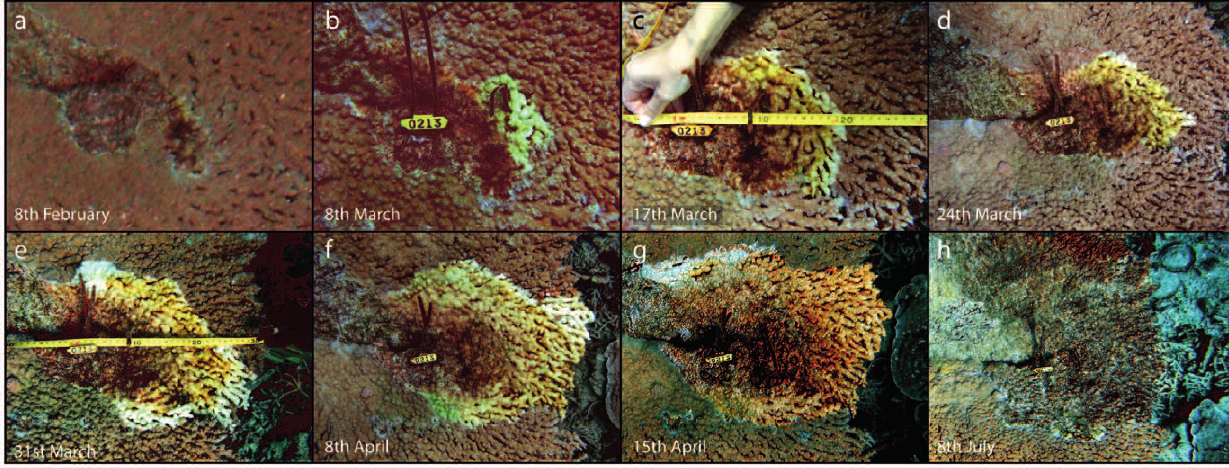
Figure 5. Initiation, formation and progression of white syndrome lesion in a colony of Acroporacytherea . Photographs taken during weekly monitoring in the summer months of 2004 (a–g) and winter (h).